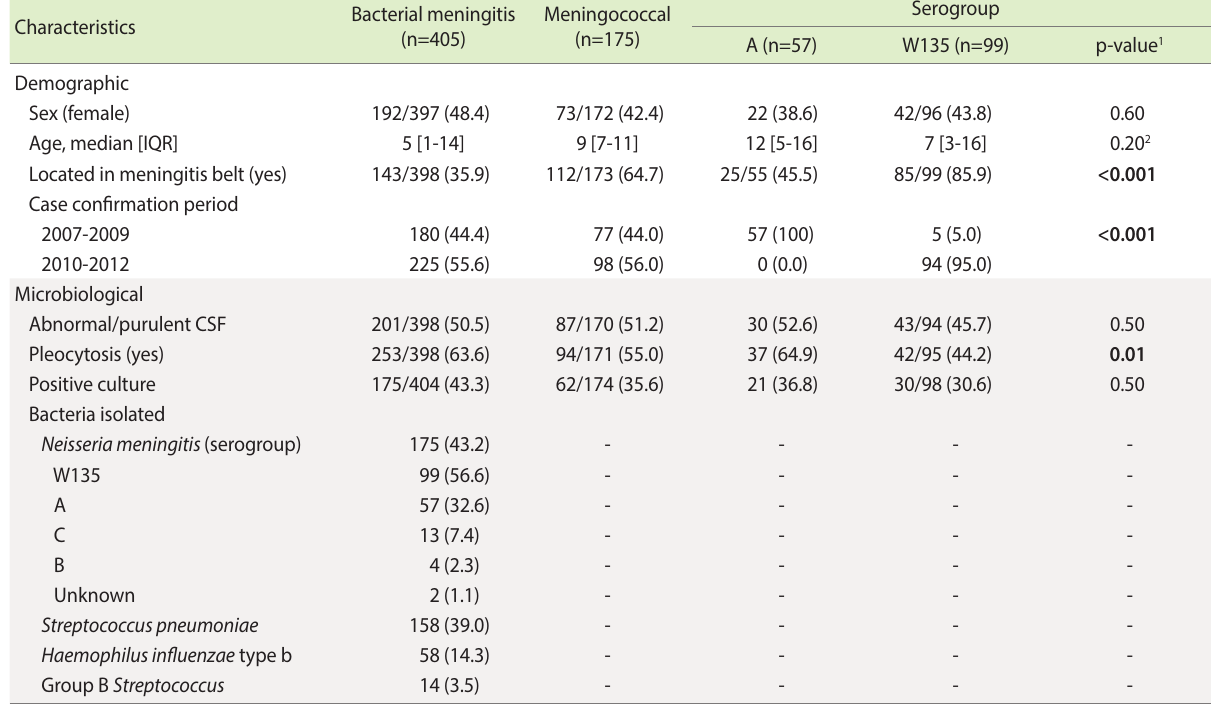
Table 1. Characteristics of cases of confirmed bacterial meningitis and meningococcal disease at the National Reference Center for